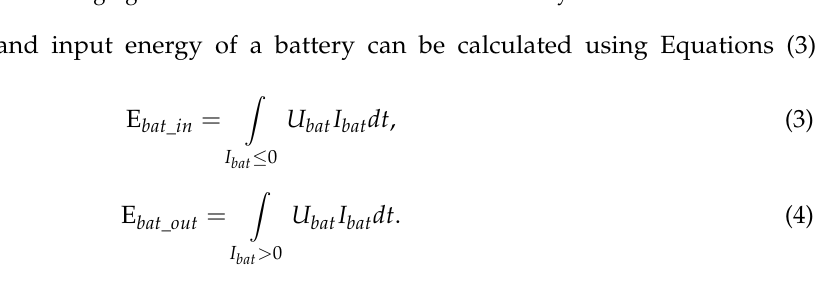
Figure 6. Charging resistance characteristics of a Li-ion